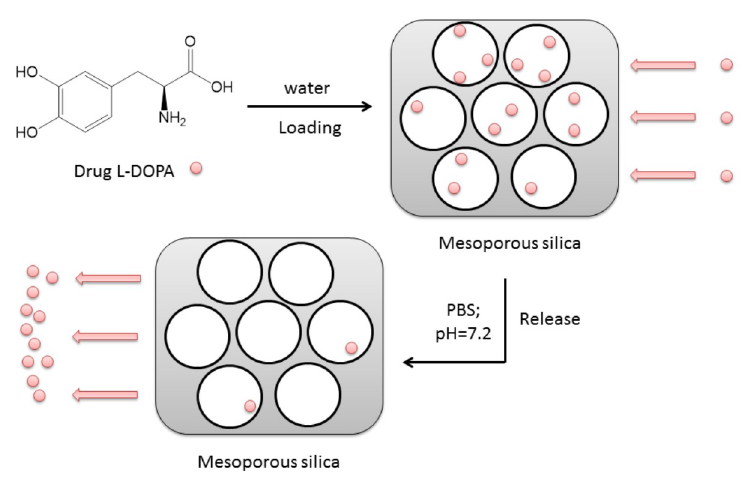
Figure 6. The illustration for L-DOPA drug loading to and release from mesoporous silica.